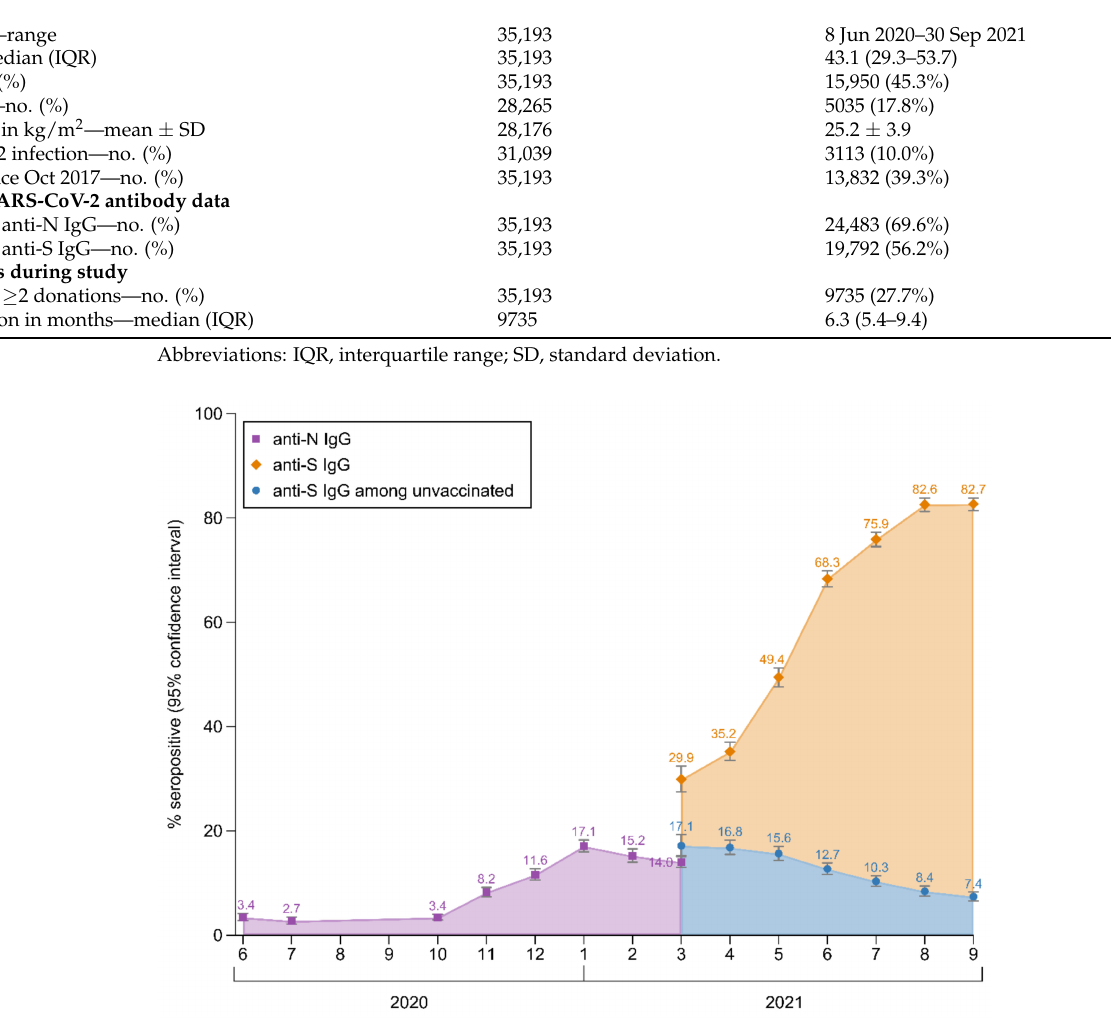
Table 1. Characteristics of participants enrolled in our study; Tyrol, Austria; June 2020–September 2021 (n = 35,193). Total No.